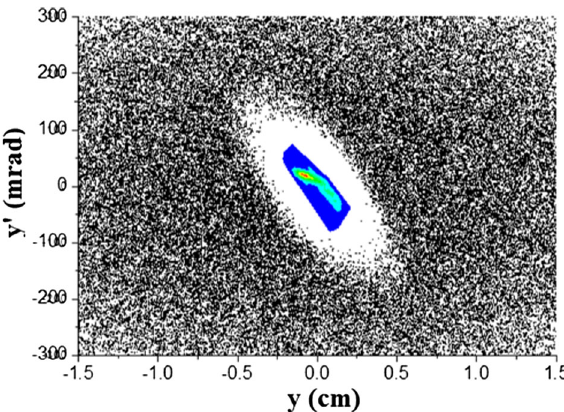
FIG. 7. Normalized vertical emittance at 85 mm after the LEBT exit.